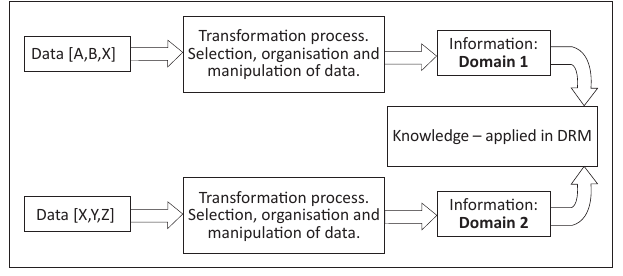
FIGURE 1: The Inter-Disciplinary Information